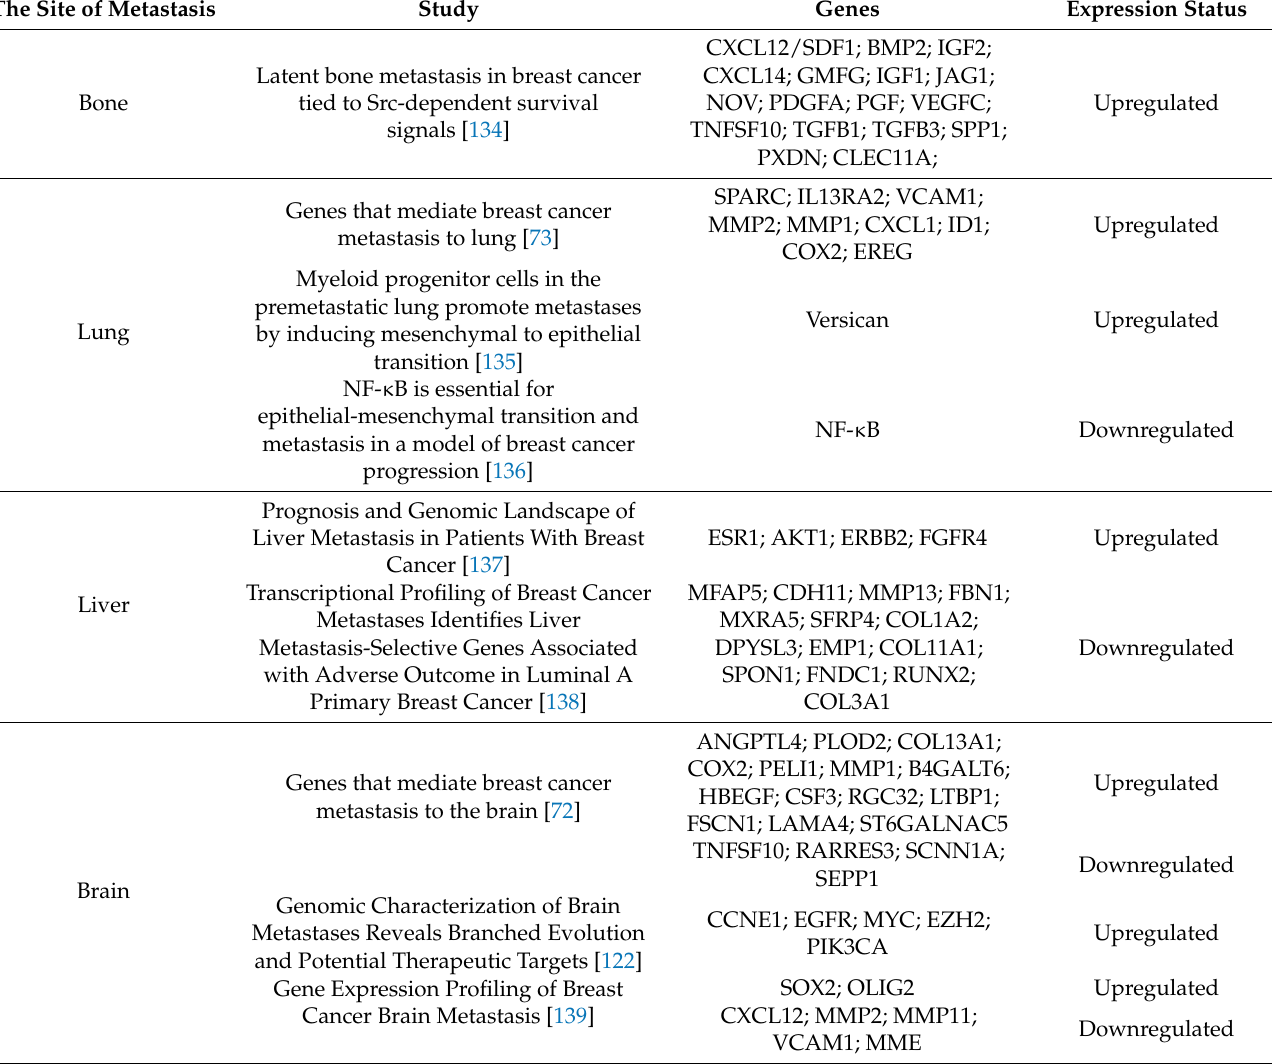
Table 1. Molecular alteration in bone, lung, liver, and brain metastasis of